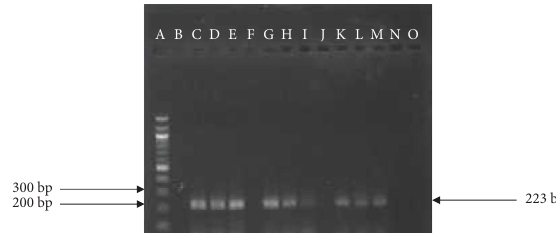
Figure 3: A 1.5% agarose gel of amplifed bcsp31 PCR products (223 bp) from cattle blood. Lane A, 100–1000bp molecular weight marker; lane B, negative control; lane C, positive control; lanes D, E, G, H, L, M, and N, positive samples; and lanes F, K, N, and O, negative samples. Table 4: Table showing the cross-tabulation of ELISA and PCR Brucella results in cattle. PCR